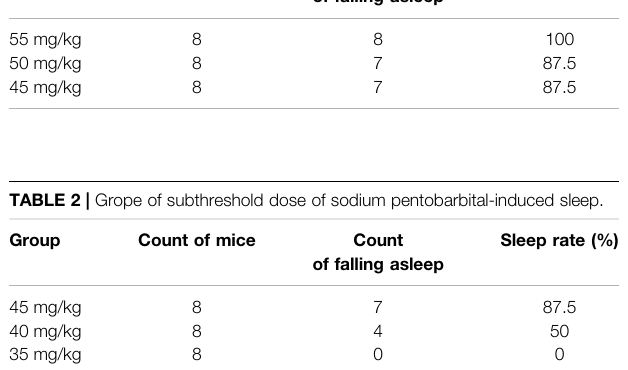
TABLE 1 | Grope of suprathreshold dose of sodium pentobarbital-induced sleep. Group Count of mice Count of falling asleep